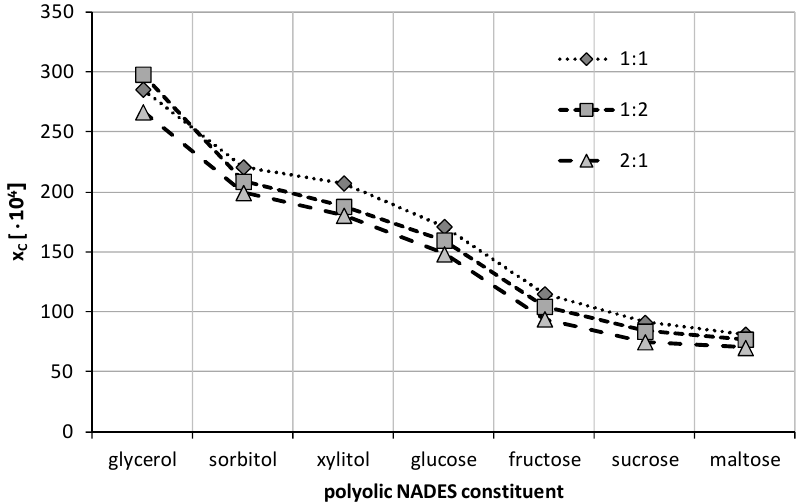
Figure 3. Mole fraction solubility of caffeine at 25 °C determined in water-free ccNADES prepared in varying molar proportions of choline chloride to sugar.